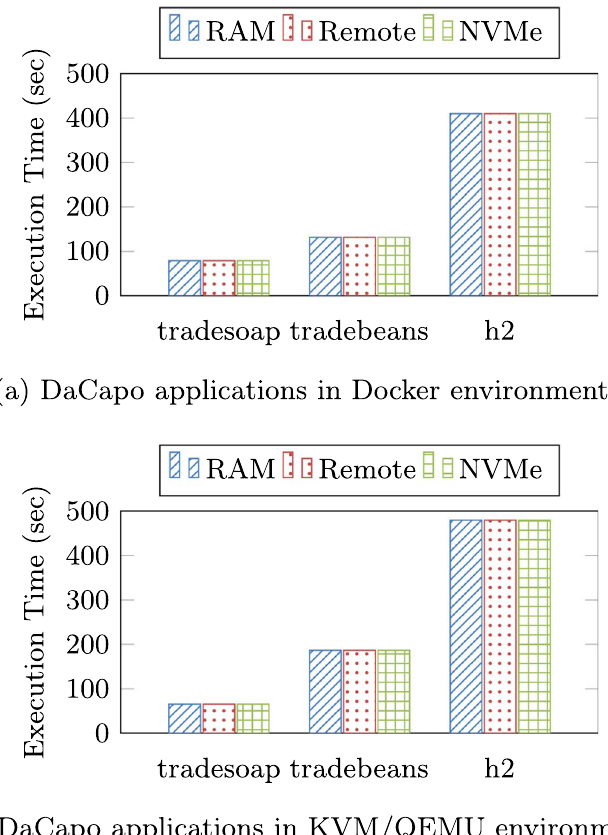
Fig. 12 Comparisons of the execution time performance averaged from 10 runs for DaCapo applications (tradesoap, tradebeans, h2) in Docker and KVM/QEMU